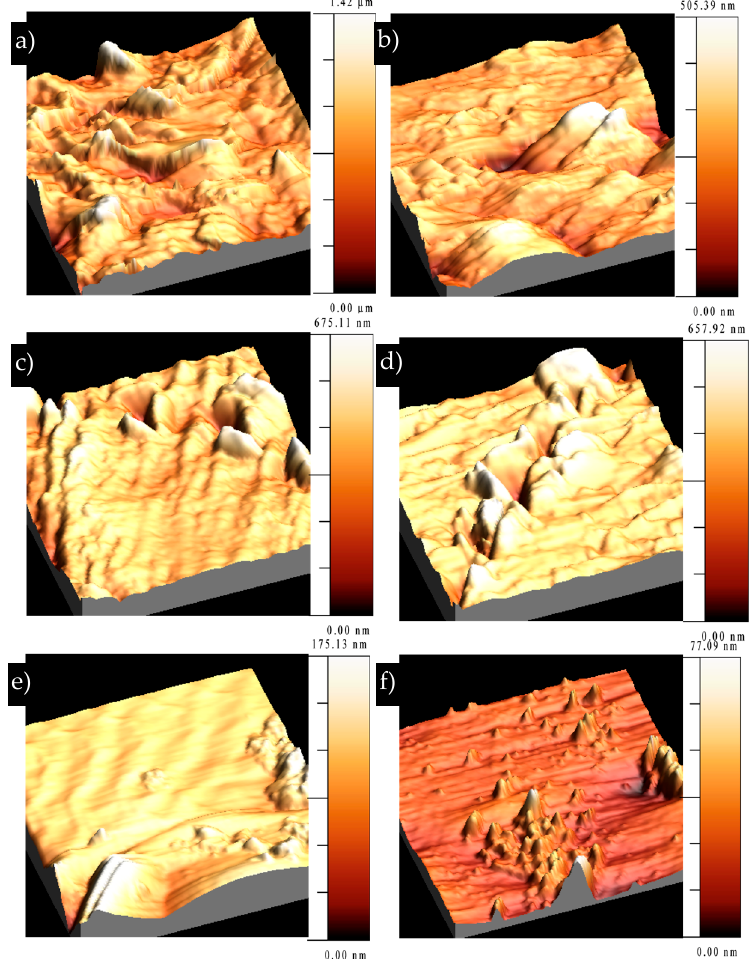
Figure 3. Representative AFM images of ( a ) cotton textile, ( b ) pretreated textile with H 2 O 2 , ( c ) composite 1, ( d ) composite 2, ( e ) composite 3, and ( f ) composite 4.